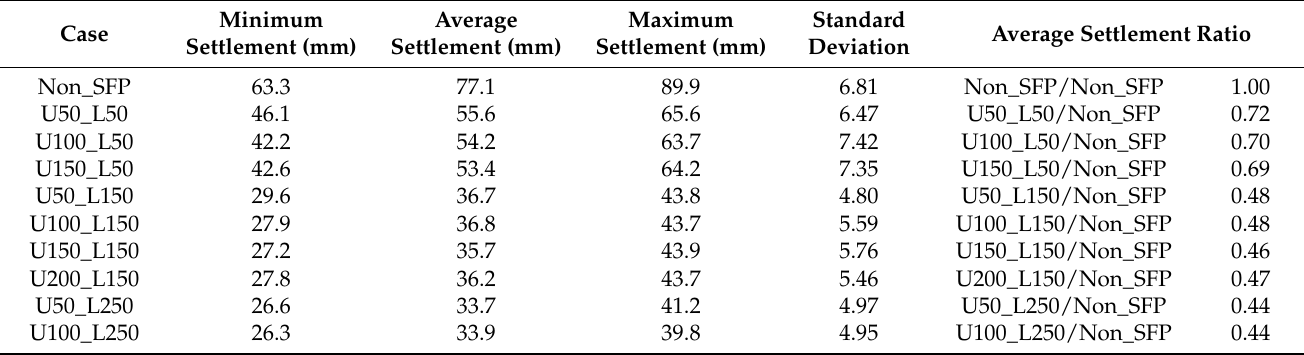
Table 4. Average settlement ratios for the various test conditions.